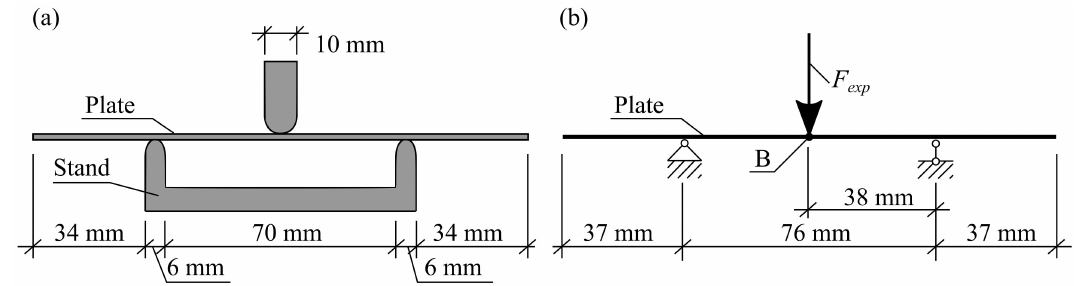
Figure 2. The principal view of the bending test device ( a ) and corresponding calculation scheme ( b